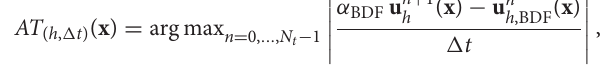
Frontiers in Physiology |